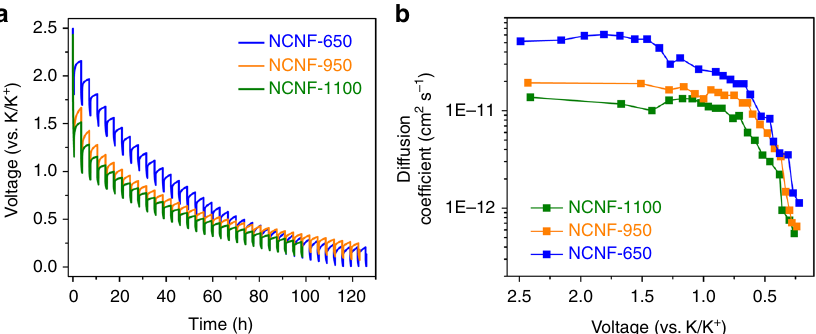
Fig. 7 Study of the K-ion diffusion coef fi cient of the NCNF electrodes. a GITT pro fi les of the discharging process. b The K-ion diffusion coef fi cient as a function of the state of